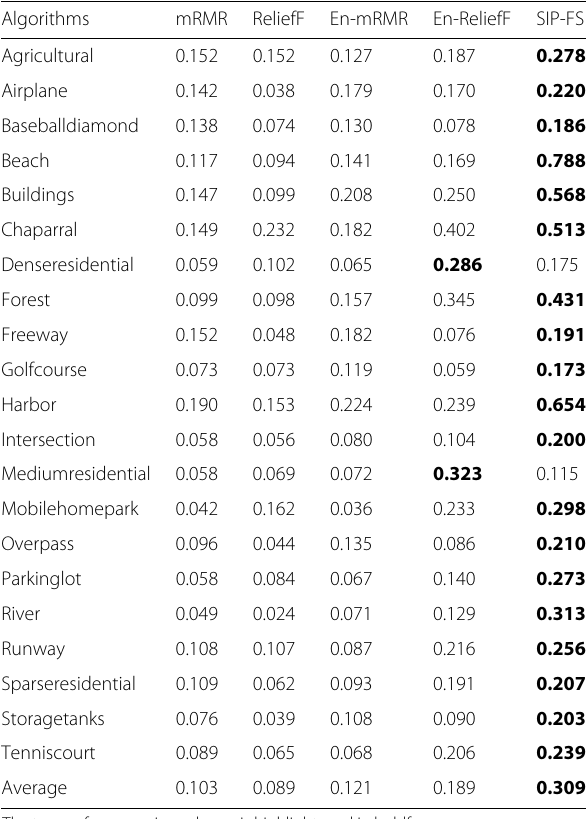
Table 3 Stability comparisons on